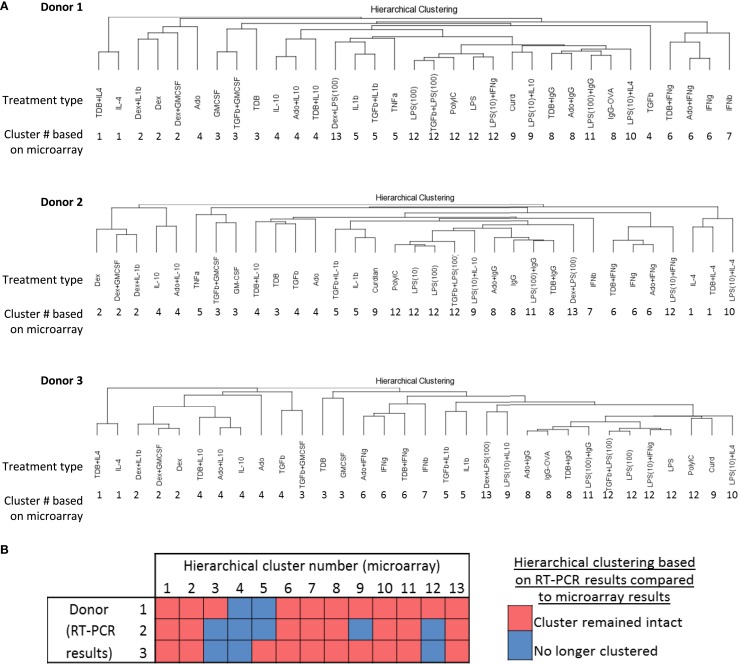
Comparing unsupervised hierarchical clustering of 33 activated macrophage types based on 1874 regulated transcripts against hierarchical clustering based on a 45-transcript subset of putative activation markers. IFC PCR was used to determine the expression of 48 transcripts in MDMs at 24 h post-treatment with 33 distinct activation conditions (columns) (N = 3). The RNA collected from the first donor had been used in the microarray studies and the RNA from two additional donors was collected in independent experiments. Data points were omitted when the ΔCt value was unreliable as defined by either the macrophage activation marker or the endogenous control not meeting the Ct cut-off of 25. (A) Unsupervised hierarchical clustering was performed using calculated ΔΔCt values derived from IFC PCR. Dissimilarity distances between gene expression profiles are displayed as dendrograms for each donor. For comparison purposes, the hierarchical cluster number is displayed below each macrophage-activating treatment type. (B) A summary is shown for comparisons between microarray-derived clusters from donor 1 and IFC PCR-derived clusters from donors 1, 2, and 3.